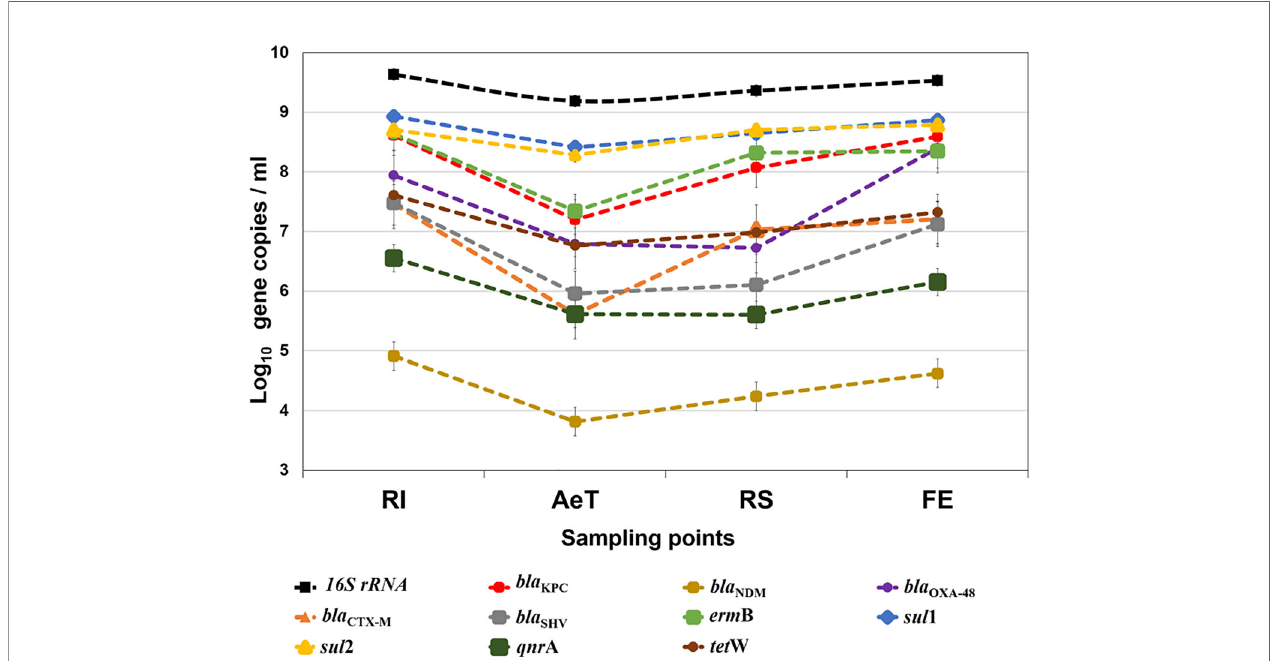
FIGURE 2 | Absolute concentration of the 16S rRNA gene and ARGs in the WWTP. The data represent the average concentrations of ARGs. The results are expressed in log 10 copies per ml. Signi fi cant differences were found in the distribution of the ARGs between the sampling points except for the sul 1, sul 2, and erm B genes. RI, raw in fl uent; AeT, aeration tank; RS, return activated sludge; FE, fi nal ef fl